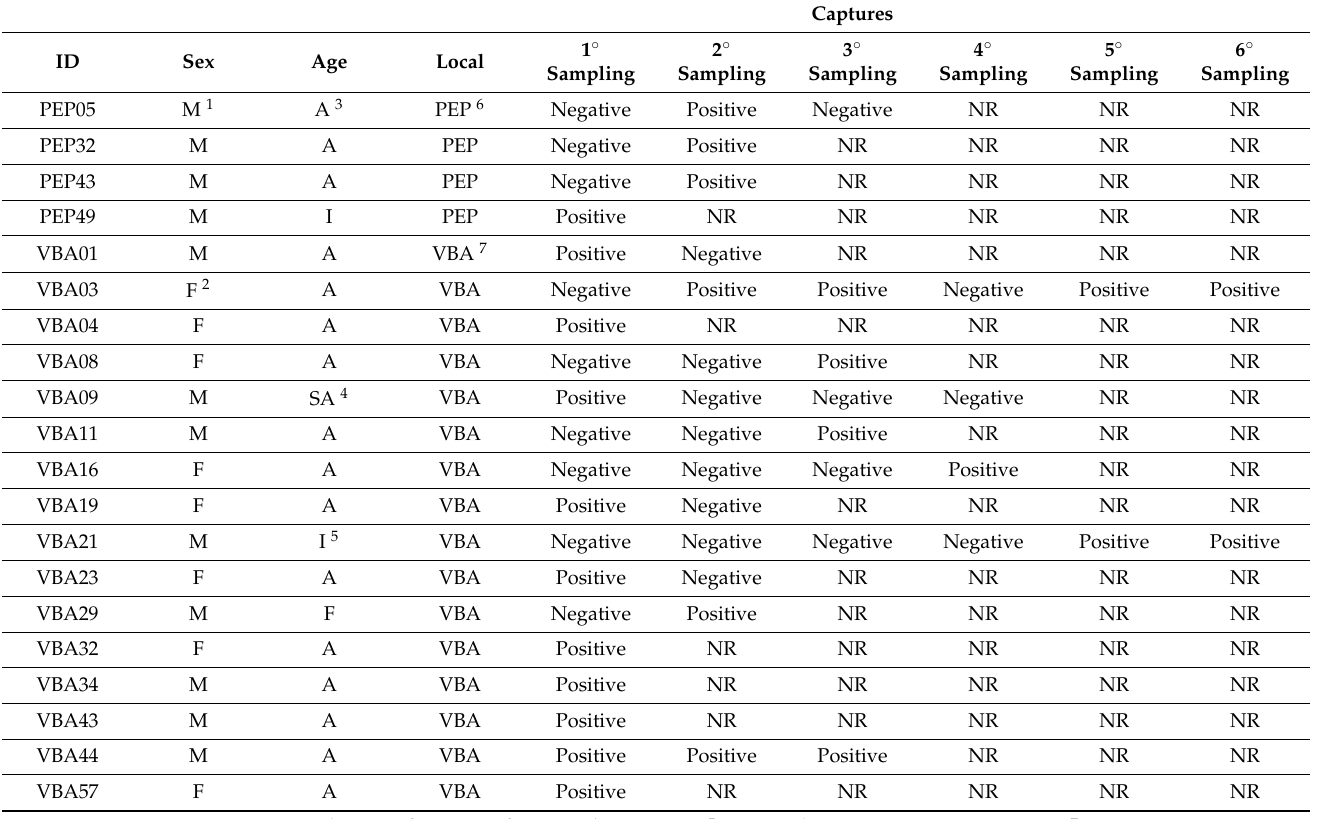
Table 1. Identification of ring-tailed coatis ( Nasua nasua ) sampled and recaptured in two areas, namely Parque Estadual do Prosa and Vila da Base A é rea, city of Campo Grande, State of Mato Grosso do Sul, Midwestern Brazil, with the identification number, sex, age and positivity in the screening PCR to Ehrlichia sp. ( dsb gene) during subsequent